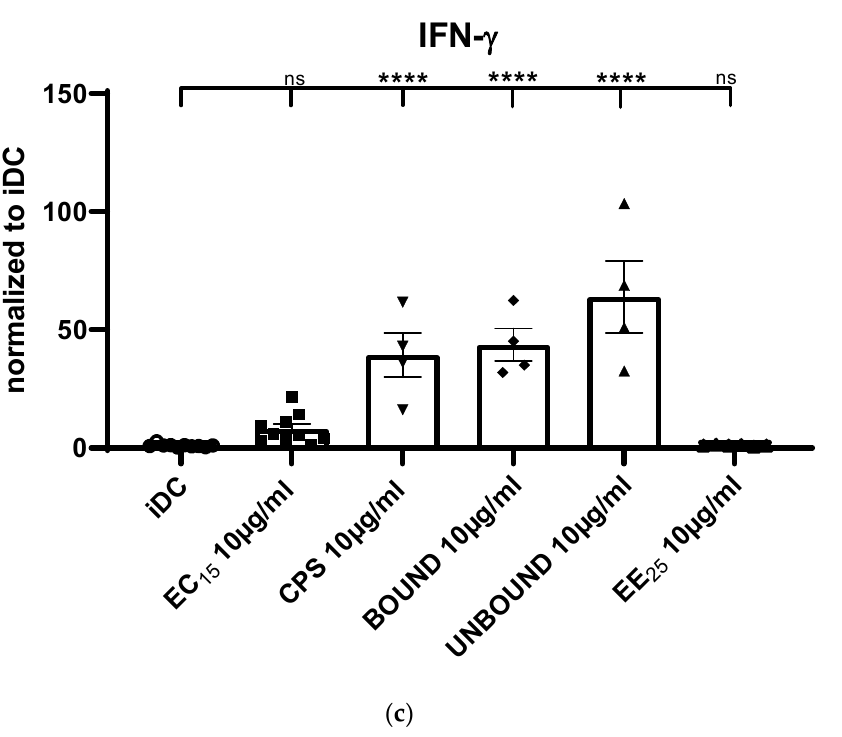
Figure 4. ( a ): IL-6 cytokine secretion into the supernatant of MLR derived co-cultures. To investigate the secretion of pro-inflammatory cytokines, generated during the DC-T-cell co-culture in the MLR assays, the supernatant was analyzed using a CBA. Asterisks mark statistically significant difference (* p < 0.05, ** p < 0.01 and *** p < 0.001). ns: no statistical significance. (n = 4–10). ( b ): TNF-α cytokine secretion into the supernatant of MLR derived co-cultures. Description as Figure 4a. Asterisks mark statistically significant difference (** p < 0.01 and *** p < 0.001). ns: no statistical significance. (n = 4–10). ( c ): IFN-γ cytokine secretion into the supernatant of MLR derived co-cultures. Description as Figure 4a. Asterisks mark statistically significant difference (**** p < 0.0001). ns: no statistical significance. (n = 4–10). Each dot represent an independent experiment.